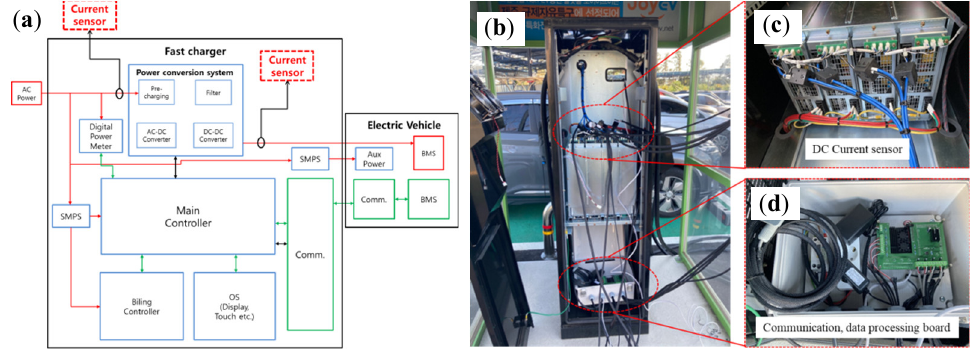
Figure 1. EV fast-charger power module failure-prediction and management system: ( a ) overview; ( b ) overall installation; ( c ) current sensor; ( d ) data-processing board.